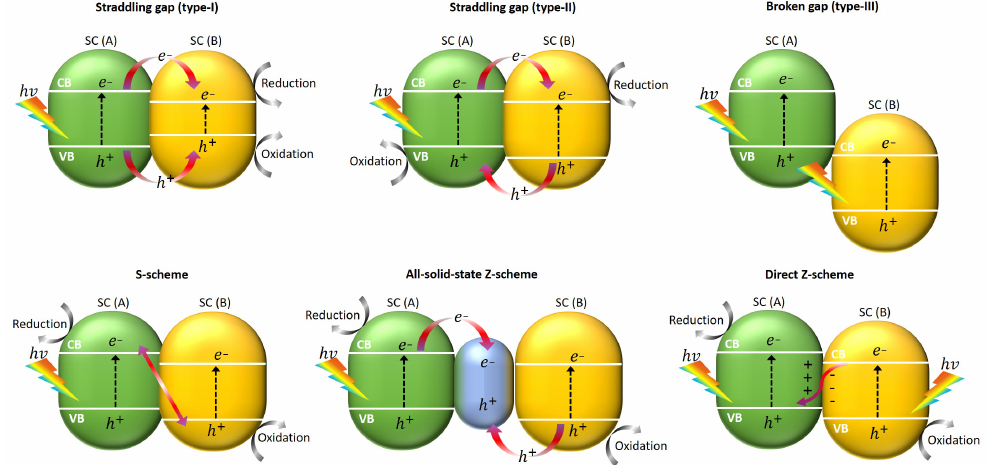
Figure 6. Schematic illustration of the most frequently reported charge transfer mechanisms for any photocatalytic systems. SC(A) and SC(B) stand for the two different semiconductor components of the corresponding